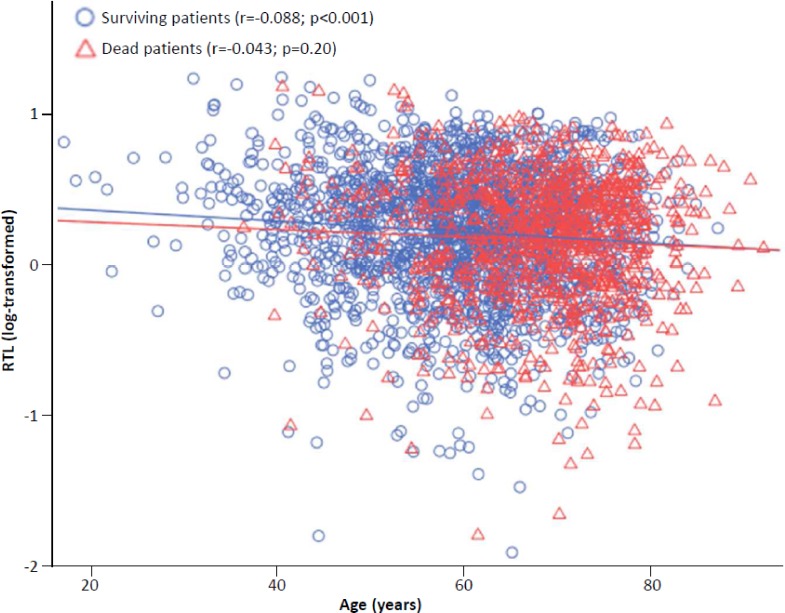
RTL as a function of age according to follow-up.Surviving patients are shown as blue circles (r = -0.088; p<0.001), deceased patients as red triangles (r = -0.043; p = 0.20).